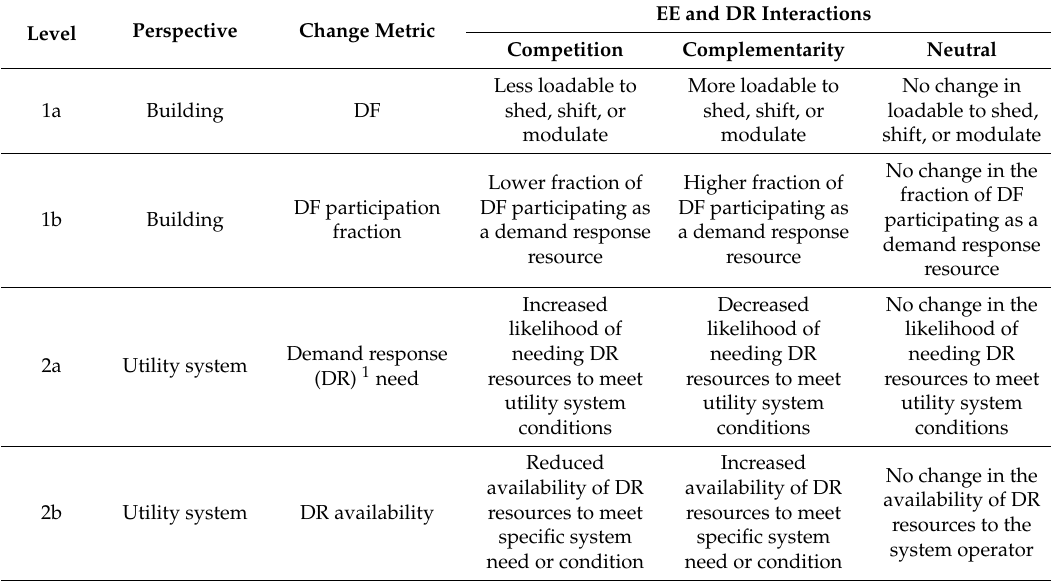
Table 1. Framework levels, change metrics, and definitions of competition, complementarity, and neutral interactions between energy e ffi ciency (EE) and demand response